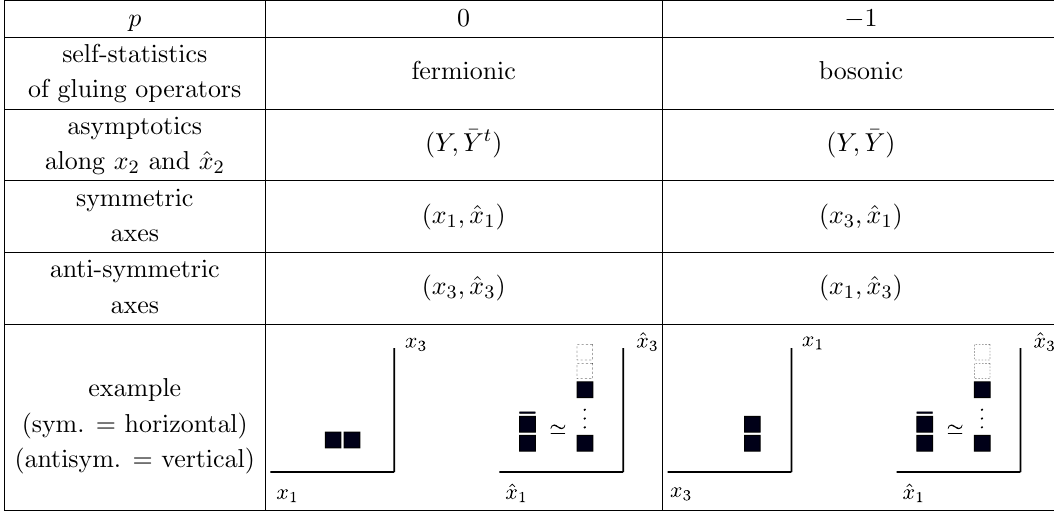
Table 2 . Relative orientations of internal asymptotic